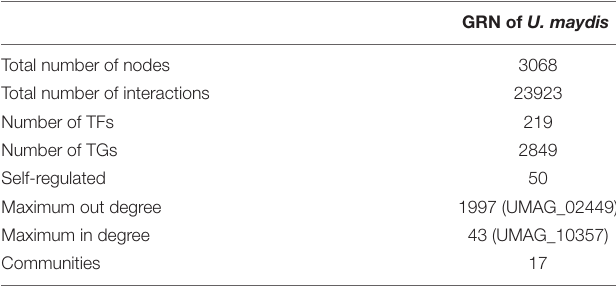
TABLE 3 | General properties of the regulatory network.